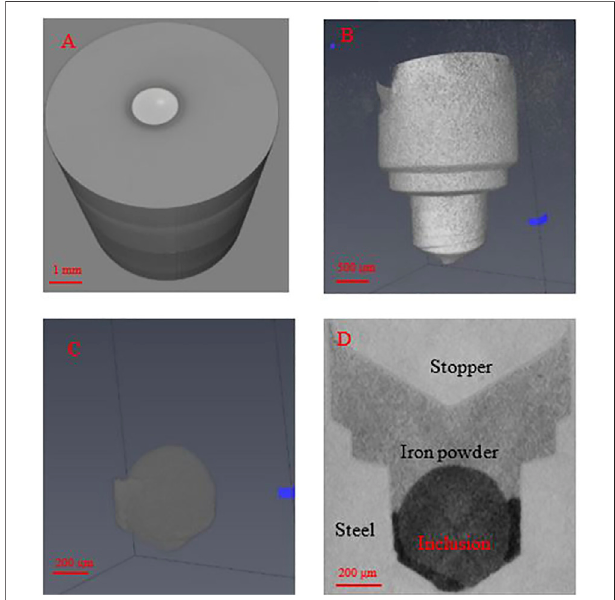
FIGURE4| CTscansofsamples. (A) Wholepellet,stoppercanbeseen. (B) Removingthe steelmatrix,the stopper withthe inclusionand iron powder. (C) Inclusion and iron powder with the inclusion being the round part. (D) Ortho slice of sample.